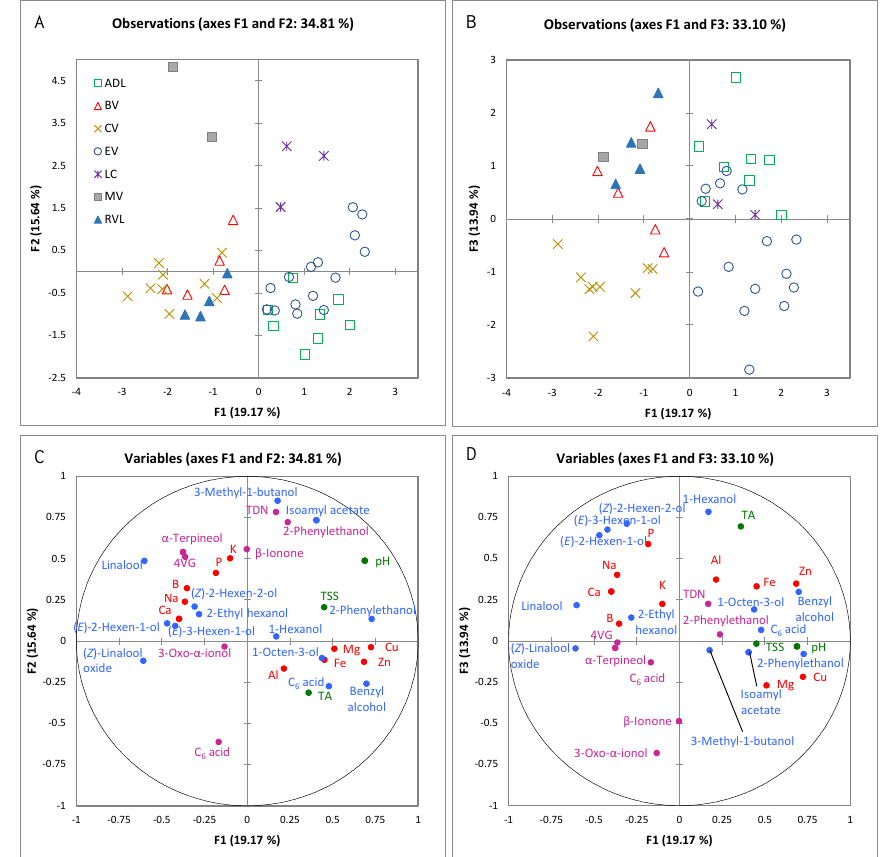
Figure 1. Multiple factor analysis (MFA) of elements, free and bound volatiles and basic chemistry data for all seven Geographical Indications (GI) in 2015, showing the scores projected on F1 and F2 ( A ) and F1 and F3 ( B ) for each GI, and loadings of variables used in the analysis on F1 and F2 ( C ) and F1 and F3 ( D ) (basic chemistry in green, elements in red, free volatiles in blue and bound volatiles in violet). ADL, Adelaide Hills; BV, Barossa Valley; CV, Clare Valley; EV, Eden Valley; LC, Langhorne Creek; MV, McLaren Vale; RVL, Riverland. Abbreviations (e.g., TSS, 4VG, TDN) are the same as specified in the